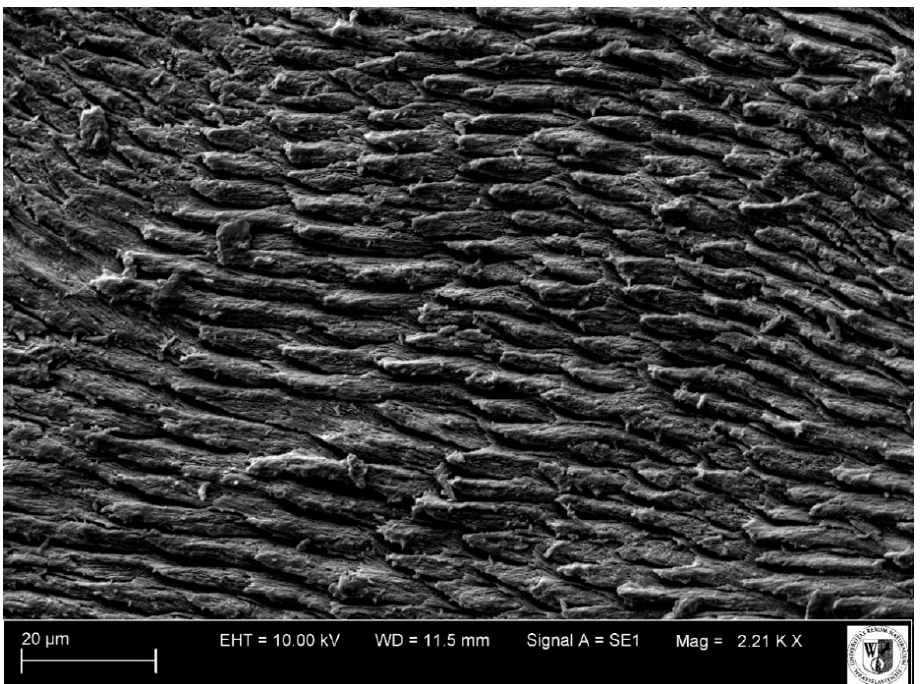
Figure 13. SEM micrograph of enamel (horizontal section through the crown), view of prisms on the P 3 mandible tooth of the white rhinoceros female.